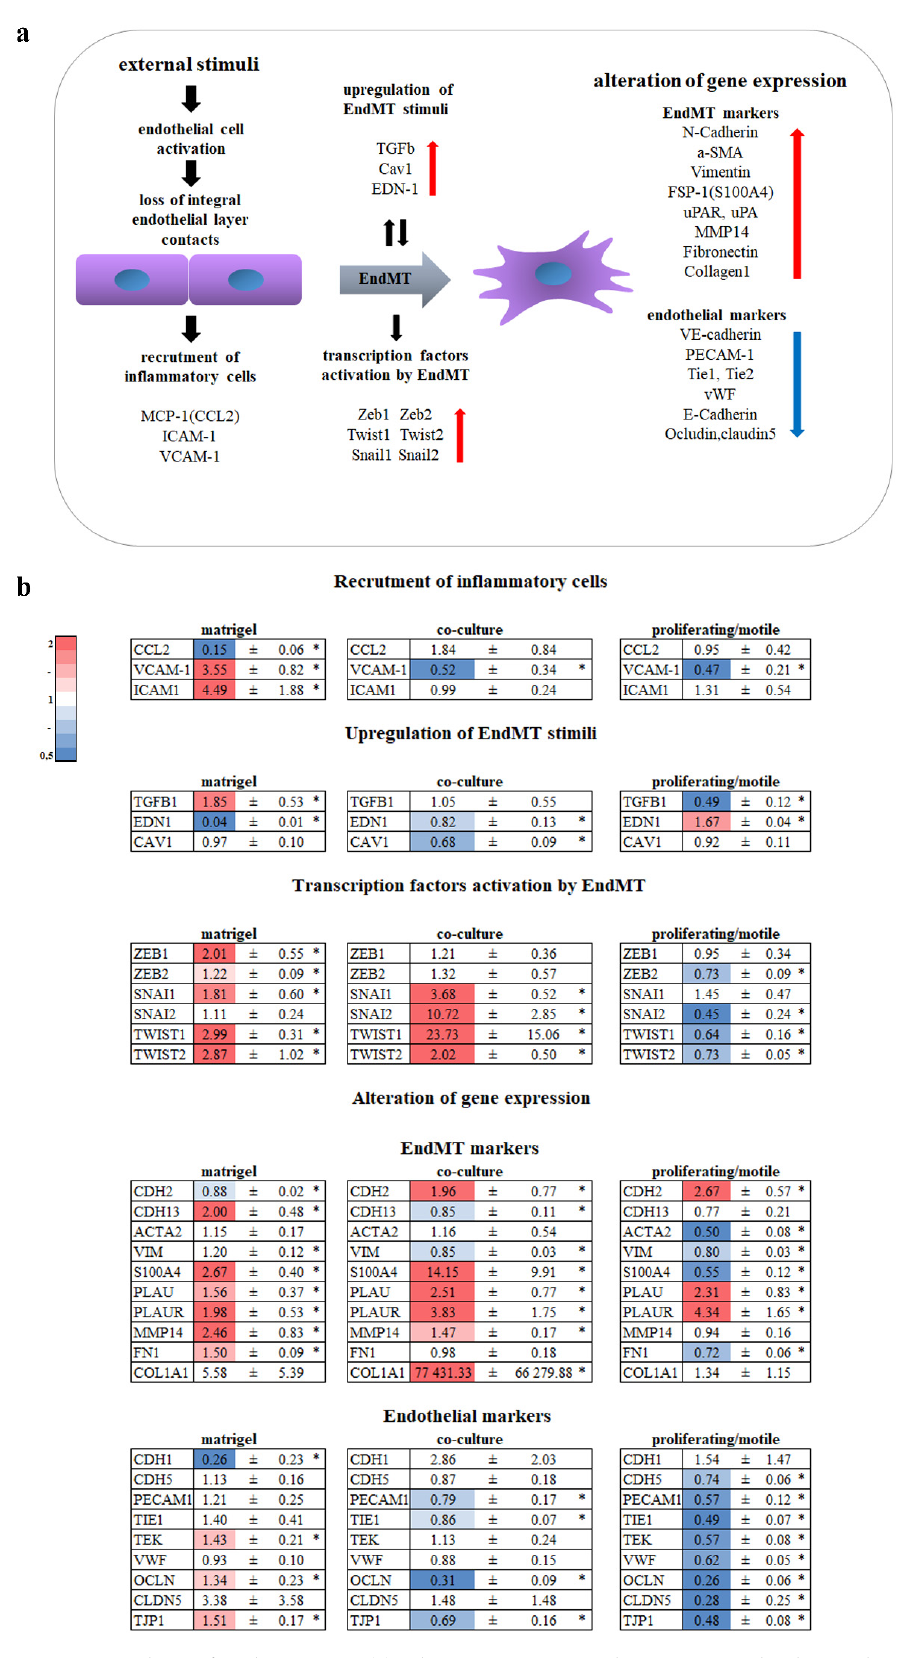
Figure 3. Analysis of EndMT genes. ( a ) Scheme summarizing key genes involved in EndMT and ana- lyzed in our research. Red arrows indicate upregulated genes and blue arrows indicate